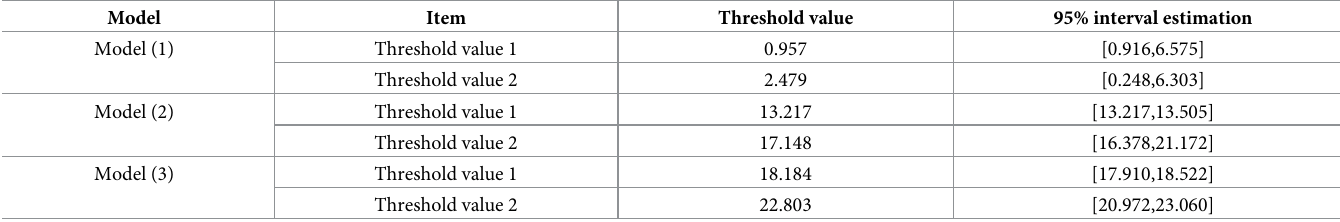
Table 2. Threshold value and confidence interval estimation.